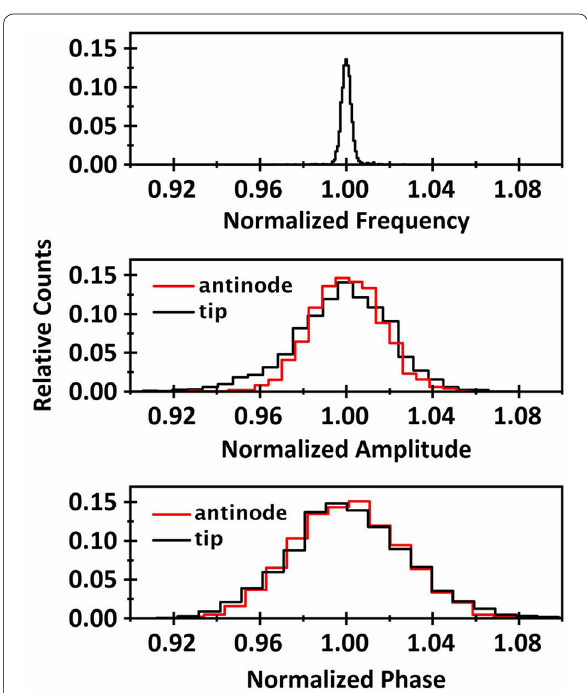
Fig. 5 Histogram comparison. Histograms of the first mode resonance frequency shift (top) and the second mode amplitude (middle) and phase (bottom) changes. All histograms are for 3500 repeated measurements with a same polystyrene microparticle of 5-μm diameter